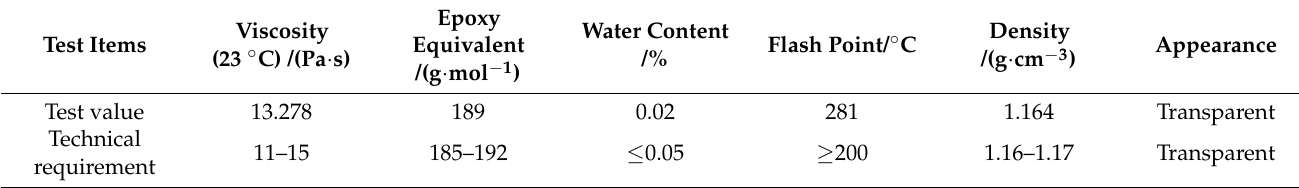
Table 2. Performance indexes of epoxy resin component A.